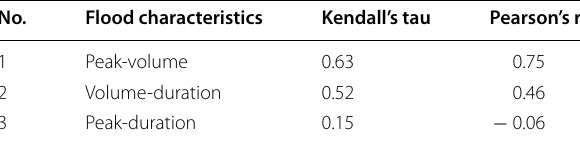
Table 5 Values of correlation coefficients for flooding